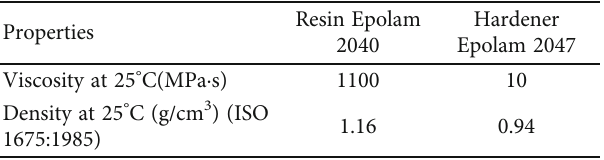
Table 1: Physical properties of resin and hardener.